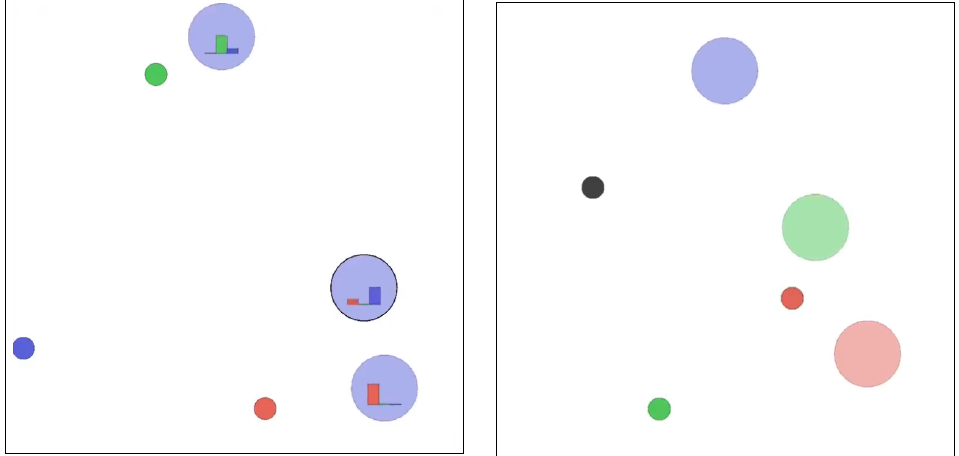
Figure 3. The tasks in this work. ( Left ): Reading out intentions of other agents. The hidden layer of the agent with the black circle is used to predict the final target of all agents, including itself. The bars inside each agent show probabilities of this agent going to the landmark of the same color. ( Right ): Generalization with “Sheldon” agents. Red and green agents always go to red and green landmarks. The trained agent in purple has to figure out it has to cover the only remaining black